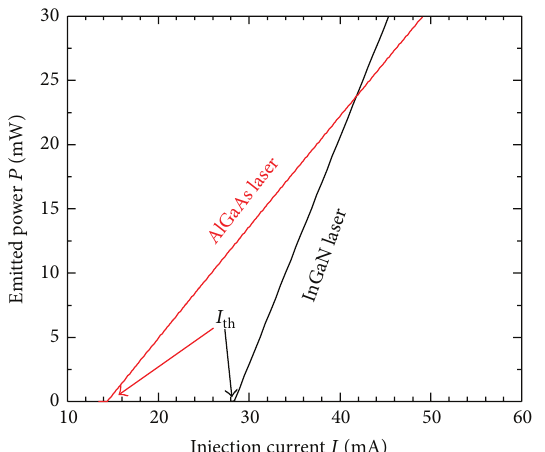
Figure 3: The 𝐿 - 𝐼 characteristics of the InGaN and AlGaAs laser diodes.